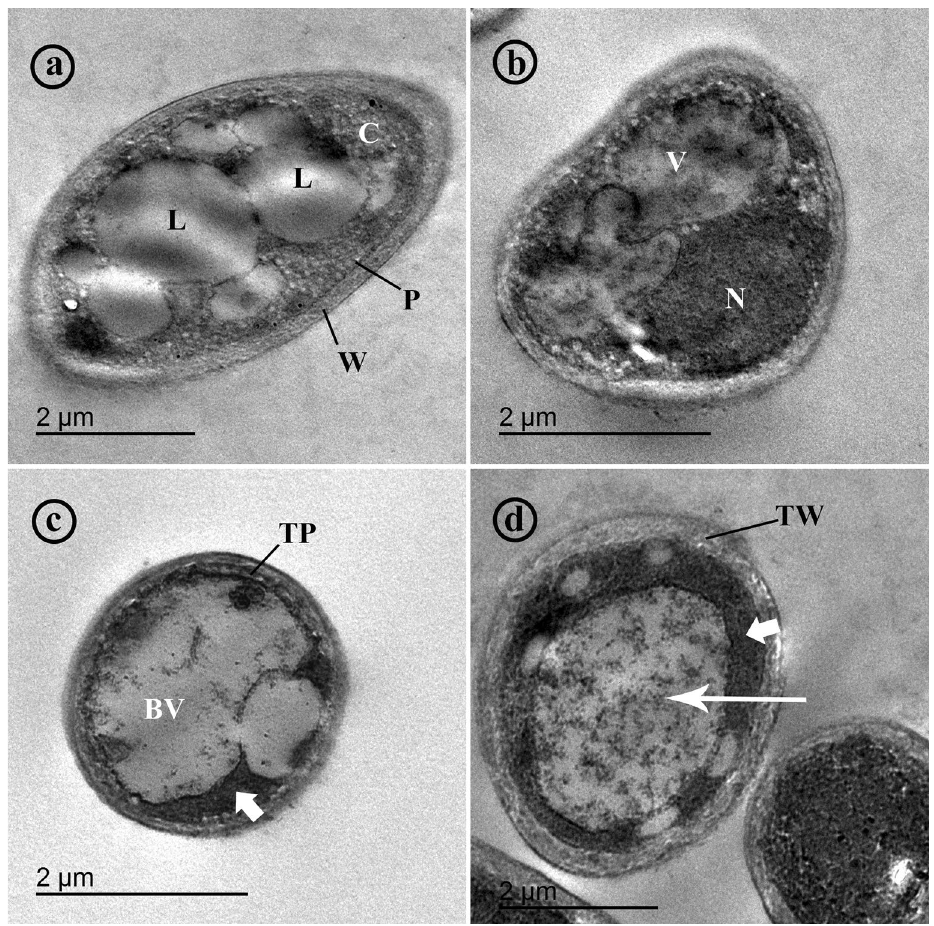
Figure 3. Transmission electron micrographs of a cross section in hyphae of Fusarium solani . Where, ( a ) and ( b ) show untreated hyphae (control). Note cell wall (W), plasmalemma (P), cytoplasm (C), lipid globules (L), nucleus (N) and vacuoles (V), while, ( c ) and ( d ) show hyphae treated with lavender essential oil at 1.25%. Note a thick plasmalemma (TP), big vacuoles (BV), electron-dense cytoplasm (short arrows), thick wall (TW) and vacuoles contain electron-dense materials (long arrow).